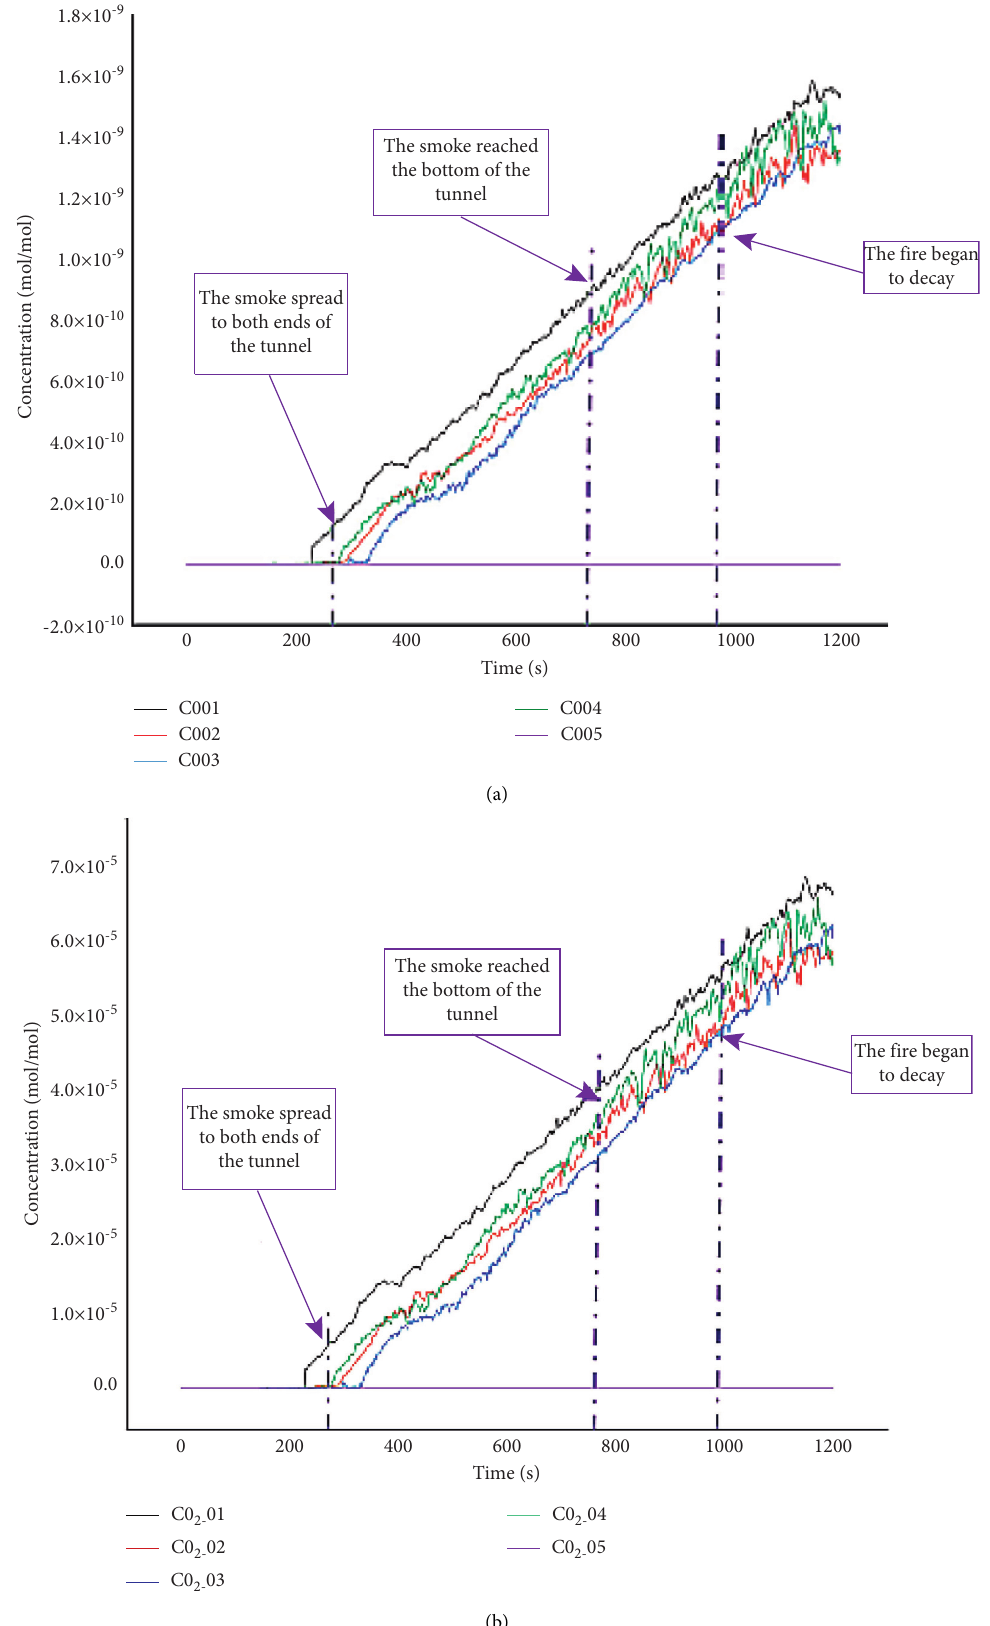
Figure 3: Comparison of smoke concentration changes under working conditions 6. (a) Carbon monoxide concentration. (b) Carbon dioxide